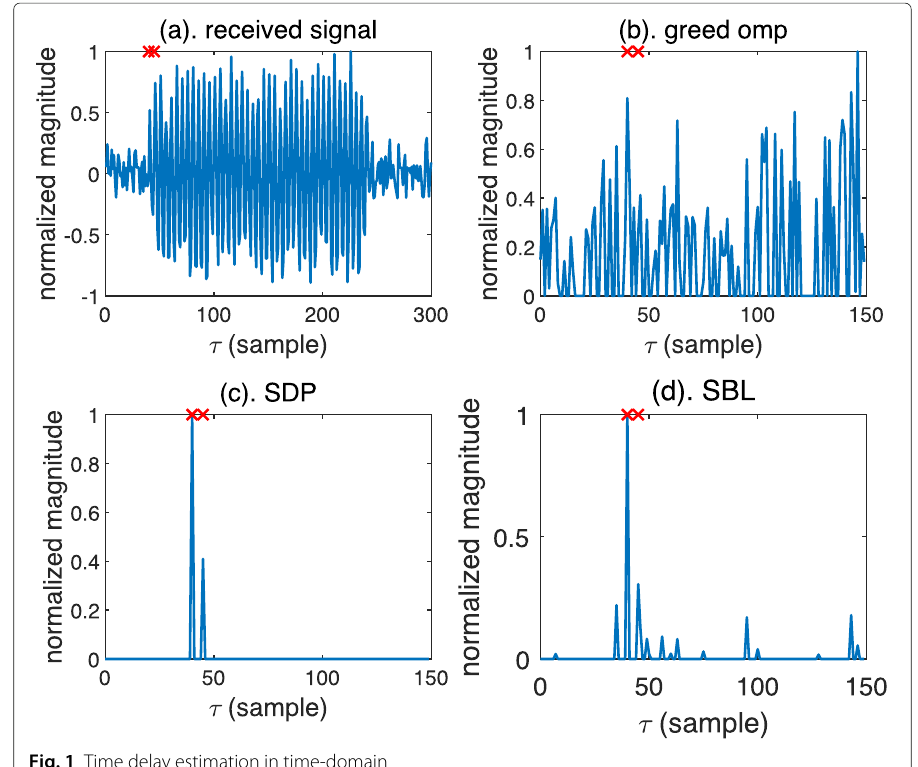
Fig. 1 Time delay estimation in time-domain